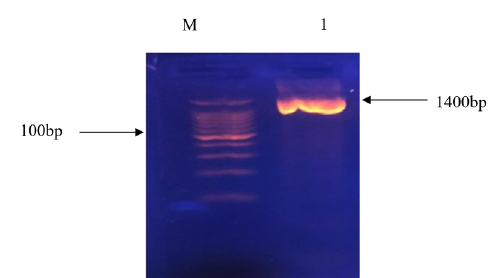
Fig. 2. Bands of agarose gel electrophoresis for 16S rRNA gene PCR product; M: 100 bp DNA marker, 1:the band size of the sample is about 1400 bp